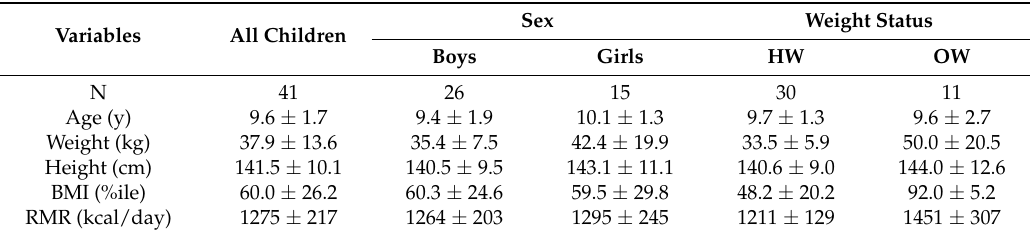
Table 2. Participant Characteristics (Means ±